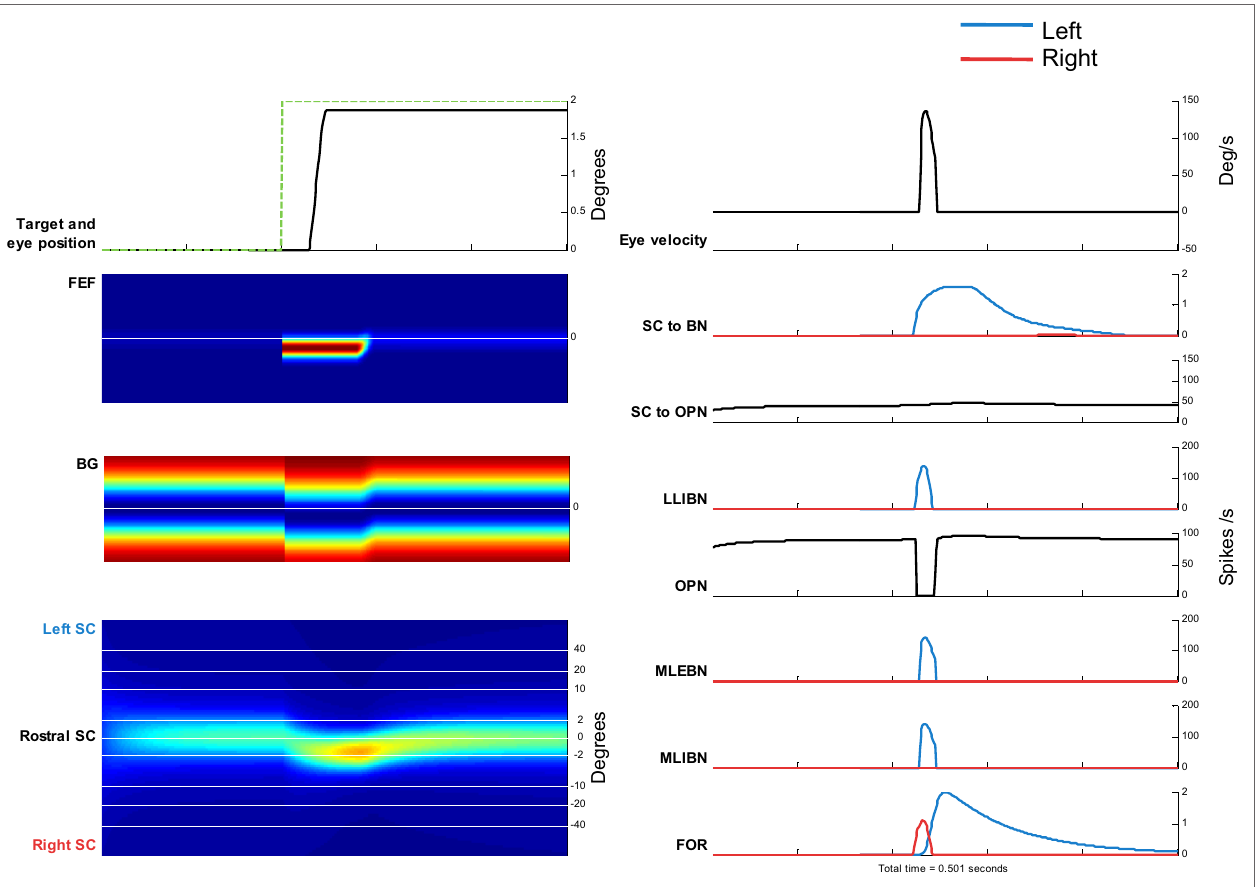
FigUre 5 | Simulation of a 2° saccade toward the right. Left side, from top to bottom: target movement and simulated eye position. Frontal eye field (FEF) activity. Basal ganglia (BG) activity. Superior colliculus (SC) activity. Color plots show evolution of activity over time in each map. Top, neurons encoding leftward movements. Bottom, neurons encoding rightward movements. Right side, from top to bottom: eye velocity. Total projection from SC to burst neurons (BNs) (left BNs in blue and right BNs in red). Total projection from SC to omnipause neuron (OPN). Firing rate of long lead IBN (LLIBN), OPN, medium lead excitatory BN (MLEBN), medium lead IBN (MLIBN), and fastigial oculomotor region (FOR)